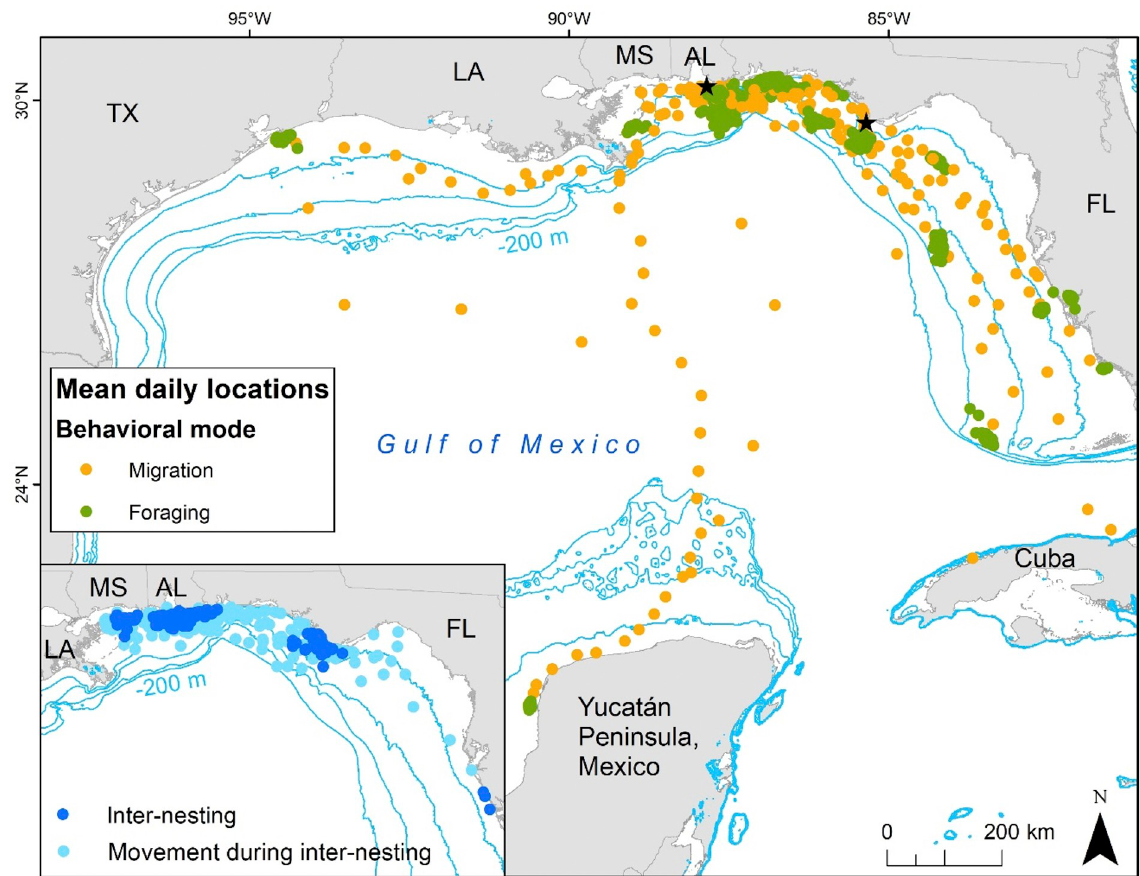
Fig 1. Mean daily locations (MDLs) of 26 adult female loggerhead turtles ( Caretta caretta ) tracks color-coded by behavioral mode. Main panel: migration and foraging MDLs; inset: inter-nesting and transit during inter-nesting MDLs (not all switching state-space model -defined transit periods were true migrations; see methods for full explanation of modes). Nesting beaches where turtles were tagged are shown with black stars and include from left to right: Gulf Shores, Alabama (AL) and St. Joseph Peninsula, Florida (FL). Contour lines indicate bathymetry at -200 m (furthest from land), -100 m, -50 m, and -20 m (closest to land).